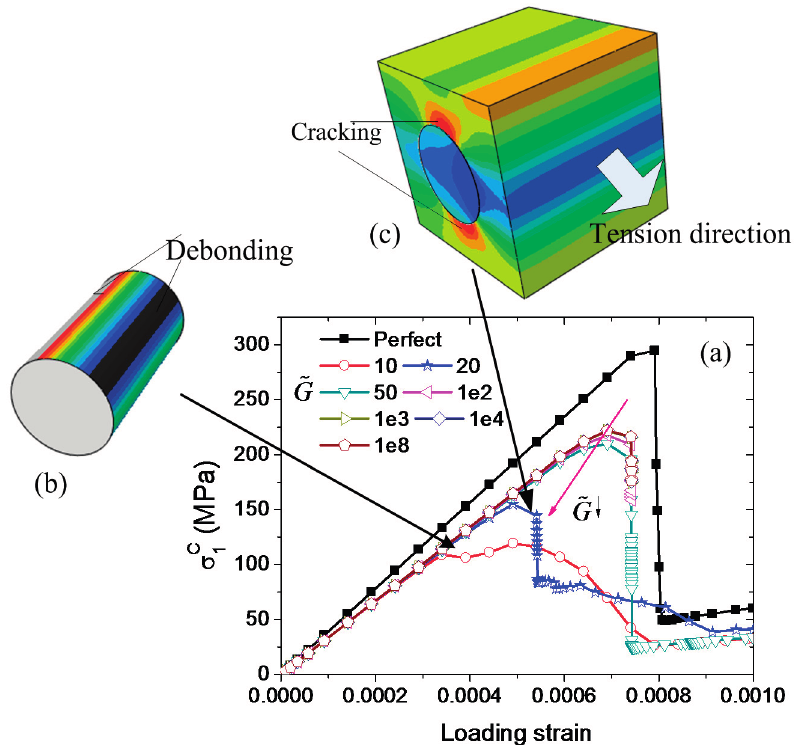
Figure 7. ( a ) Simulated macroscopic stresses with respect to the loading strain for the C/SiC composites with different interfacial fracture energy subject to transverse tension along y 1 direction; inset ( b ) debonding on the interface; and ( c ) cracking near the interface in the matrix. The black arrows point different loading strain, and the red arrow represents  the descent direction of G